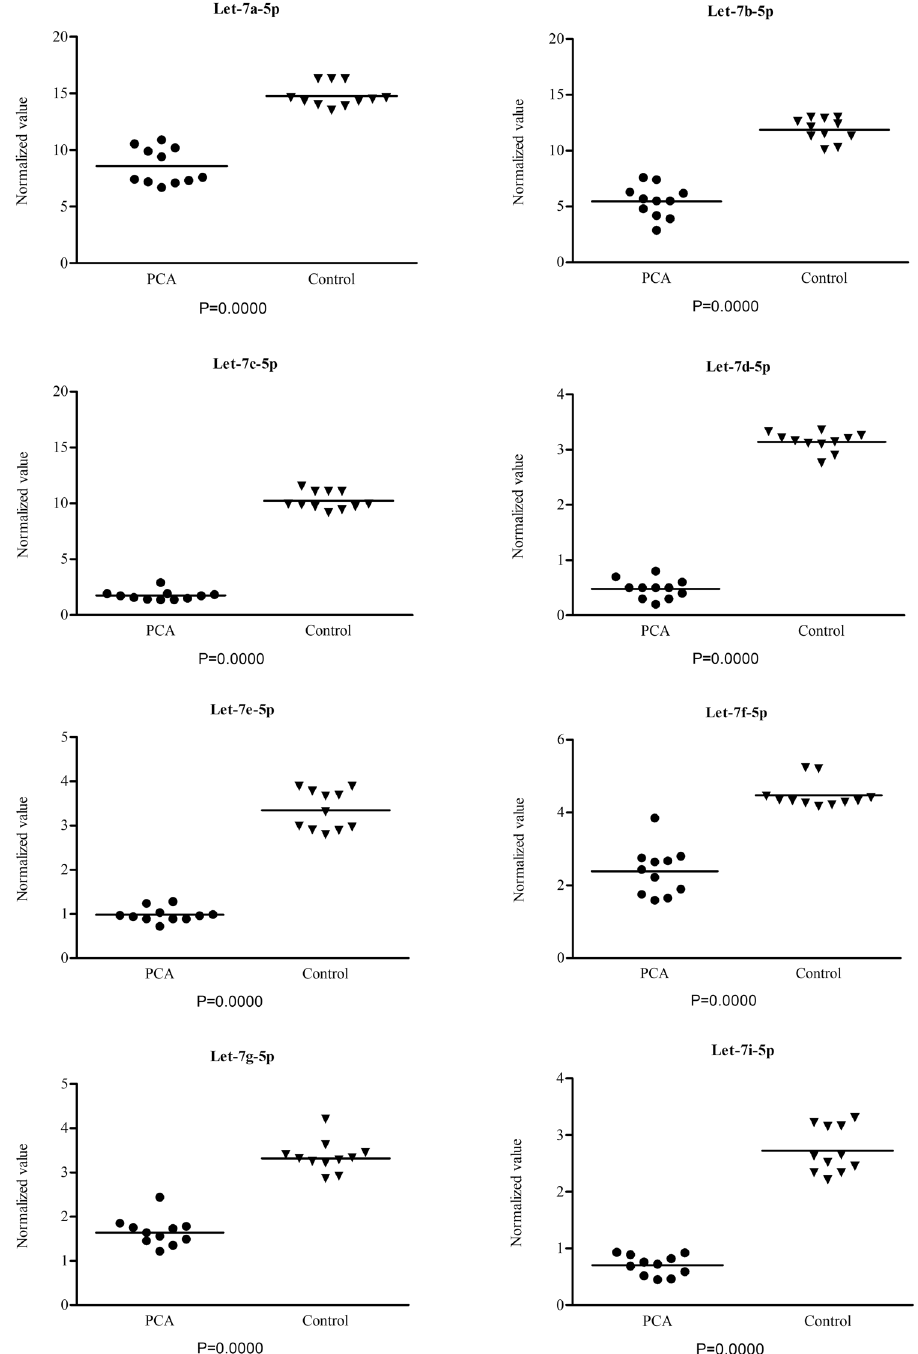
Figure 4. MiRNA expression levels. Normalized expression value (2 −Δ Ct ) of let-7 family miRNAs in post-DRE urine sediments from PCa (left) and controls subjects. The solid symbols show the observed subjects and the bar indicate the mean of observations. The 2 −Δ Ct method was used to calculate the miRNAs normalized expression as follows: 2 − (Ct target miRNA − Ct miR-191)